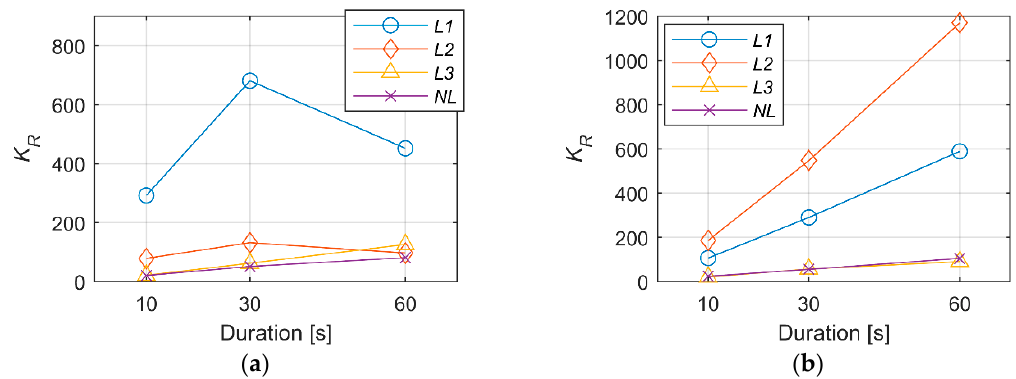
Figure 8. Trend of K R as function of the acquisition duration for Hyd signals: ( a ) Test-1; ( b ) Test-2.